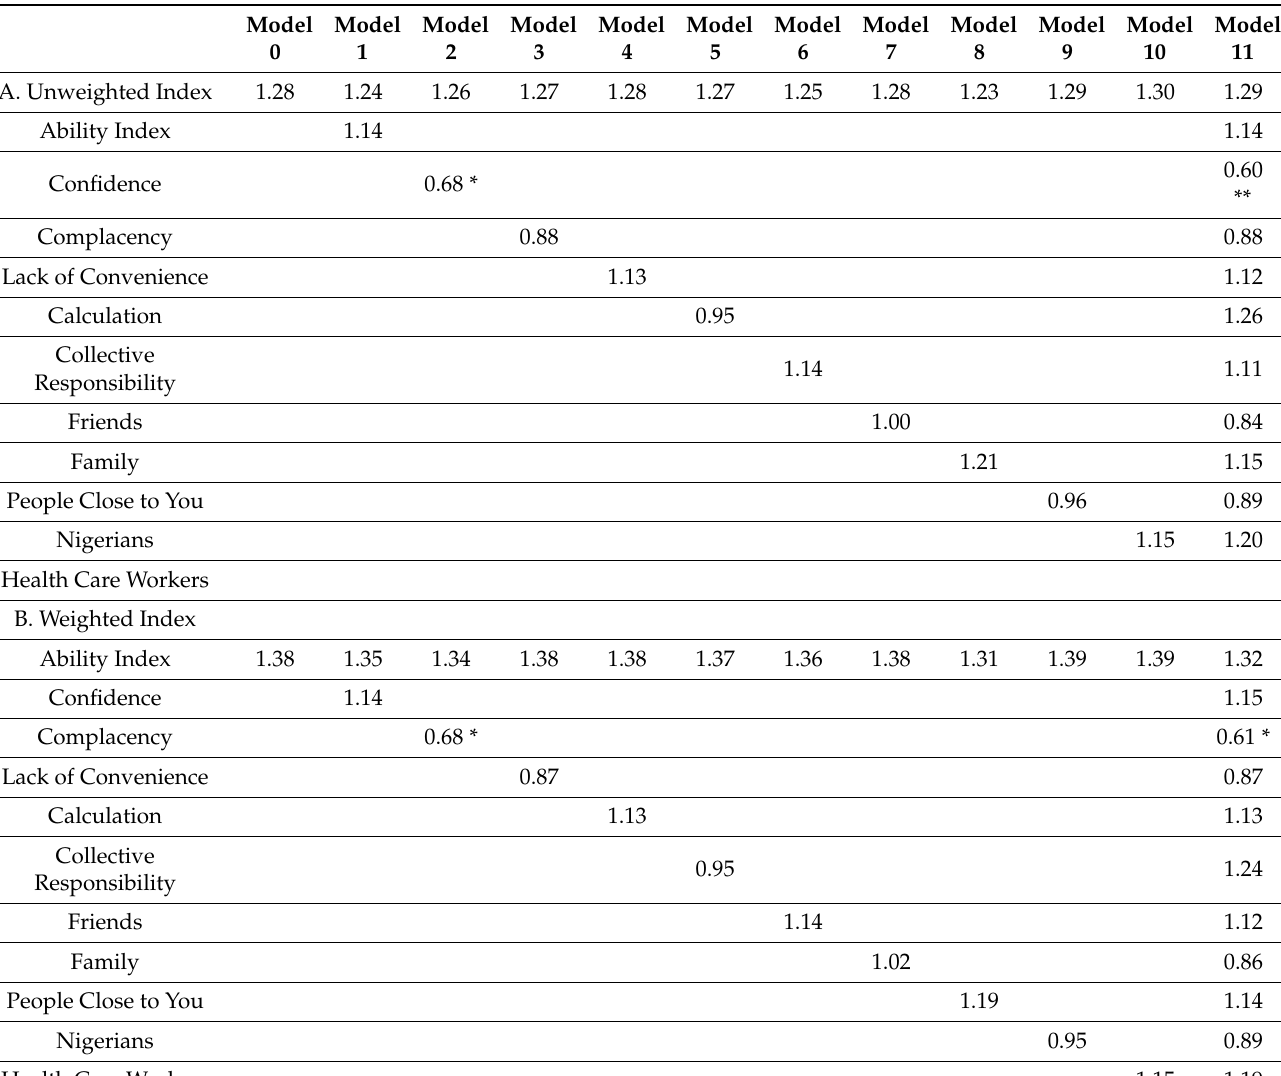
Table 7. Prospective associations of the ability index with vaccination, without and with control for five Cs and social norms indicators ( n =